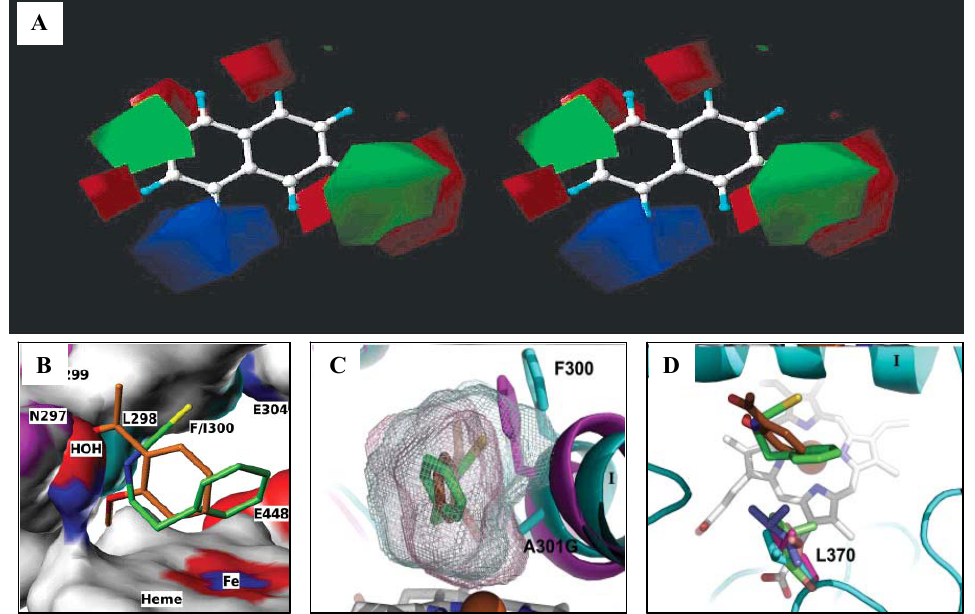
Figure 3. ( A ) Stereo figure of color contour maps of CYP2A6 CoMFA with the LUMO field. Areas where more negative partial charge and bulkier groups increase binding affinity are represented in red and green, respectively. Blue and yellow represent areas where more negative partial charge and bulkier groups decrease binding affinity, respectively. The reference structure is 2-fluoronaphthalene. (Figure adapted from the reference [45]); ( B ) Results of COMBINE analysis. Electrostatic features as gauged from COMBINE analysis are depicted for the high-affinity ligand (phenethyl isothiocyanate colored green bound to CYP2A13) and low-affinity ligand (2-methoxyacetophenone colored orange bound to CYP2A6). The protein surface is a composite of the highly conserved CYP2A6 and CYP2A13 structures, with features colored as follows: blue, favorable electropositive; red, favorable electronegative; cyan, unfavorable electropositive; magenta, unfavorable electronegative; ( C ) high- and low-affinity ligands-phenethyl isothiocyanate and methoxyacetophenone colored as in B, represented in the presence of steric features as gauged from COMBINE analysis represented with the CYP2A13 parental protein (cyan ribbons and mesh) and the CYP2A13 A301G mutant protein (magenta ribbons and mesh). Voids were calculated by VOIDOO; ( D ) conformational variation of Leu370 as a function of the CYP2A active site (CYP2A6, green; CYP2A13, cyan; CYP2A13/L366I, salmon; CYP2A13/G369S, blue; CYP2A13/H372R, magenta) with the bound ligands phenethyl isothiocyanate and methoxyacetophenone (colored as in B) are shown for reference. Figure (B), (C) and (D) have been adapted from reference